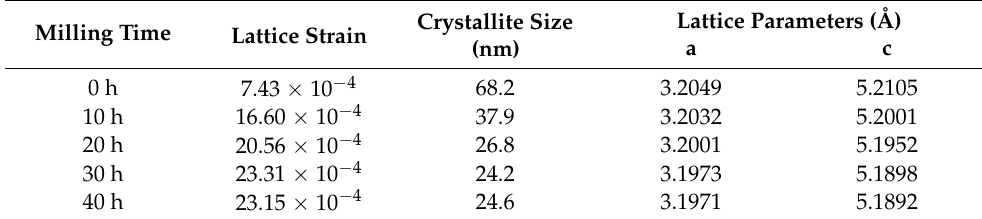
Table 1. Crystallite size, lattice strain, and constant values of the Mg matrix.